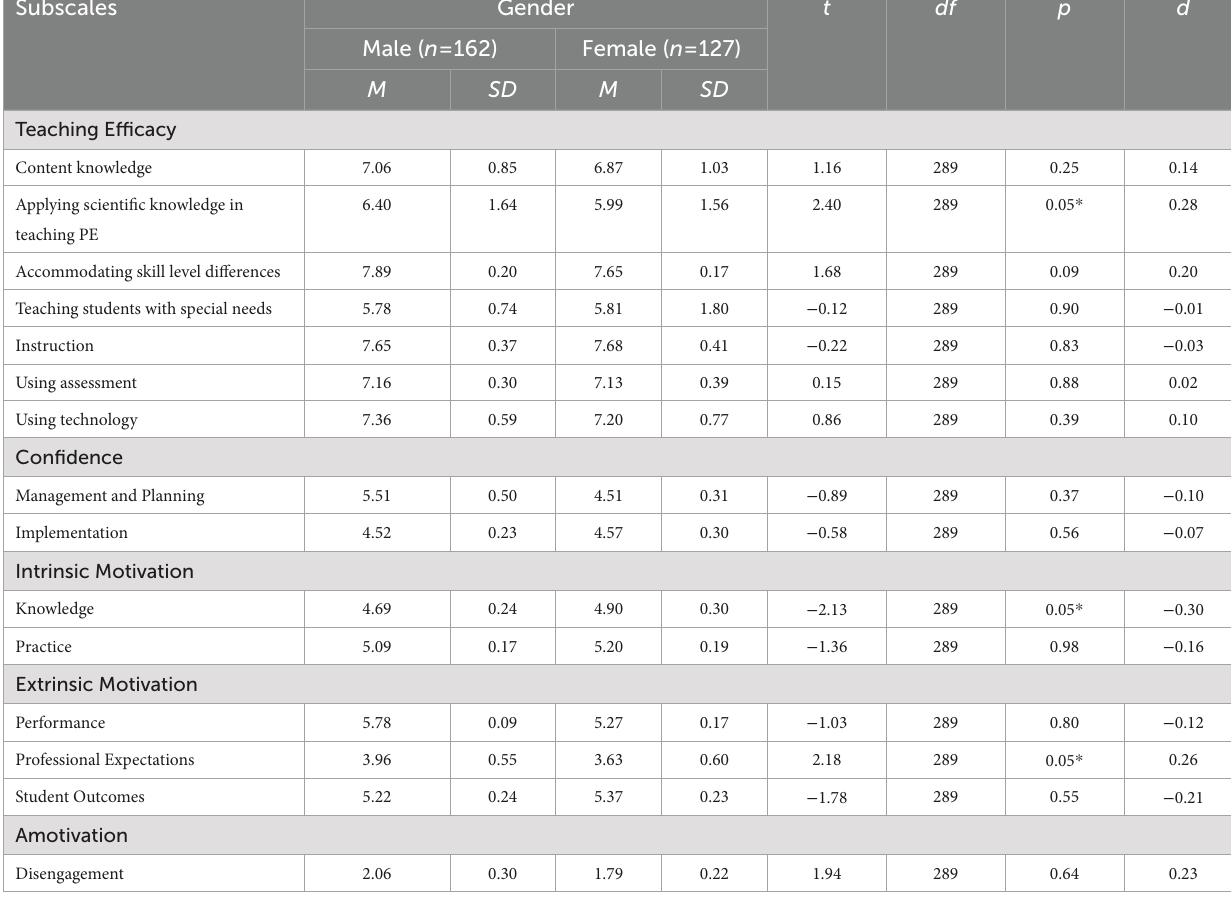
TABLE 4 Descriptive statistics and t -test results for teaching efficacy, confidence, and motivation subscales by